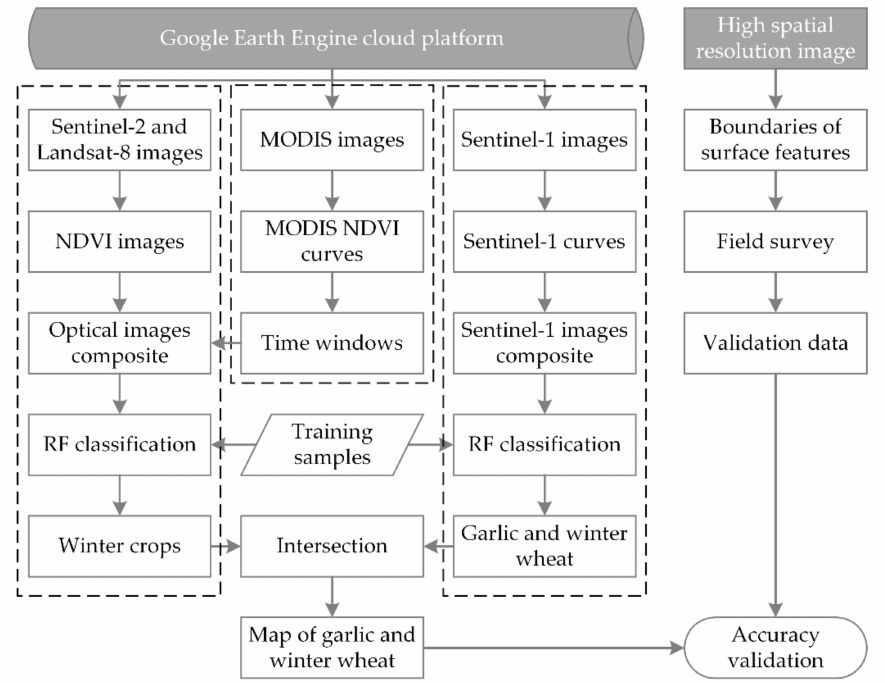
Figure 2. Workflow for mapping garlic and winter wheat based on Sentinel-1 and Sentinel-2